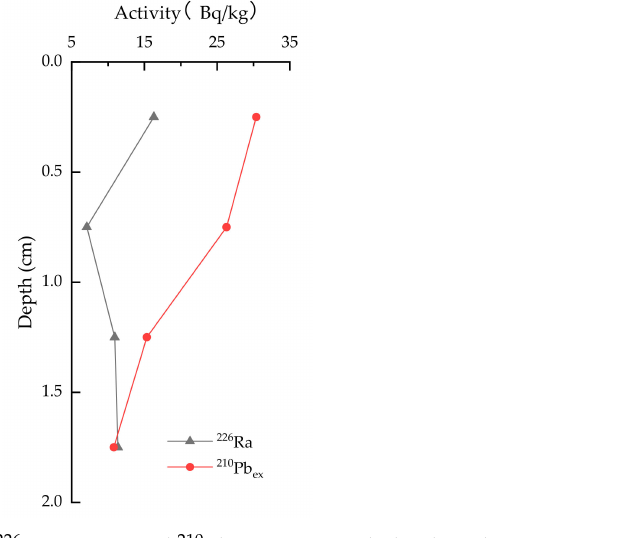
Figure 2. Vertical variation of 226 Ra activity and 210 Pb ex activity with depth in the ZH-4